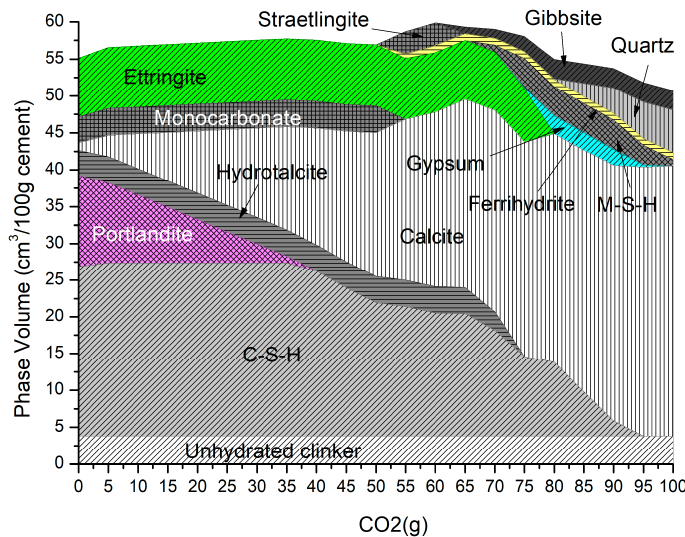
Figure 3. Phase assemblage with increasing CO 2 (g).